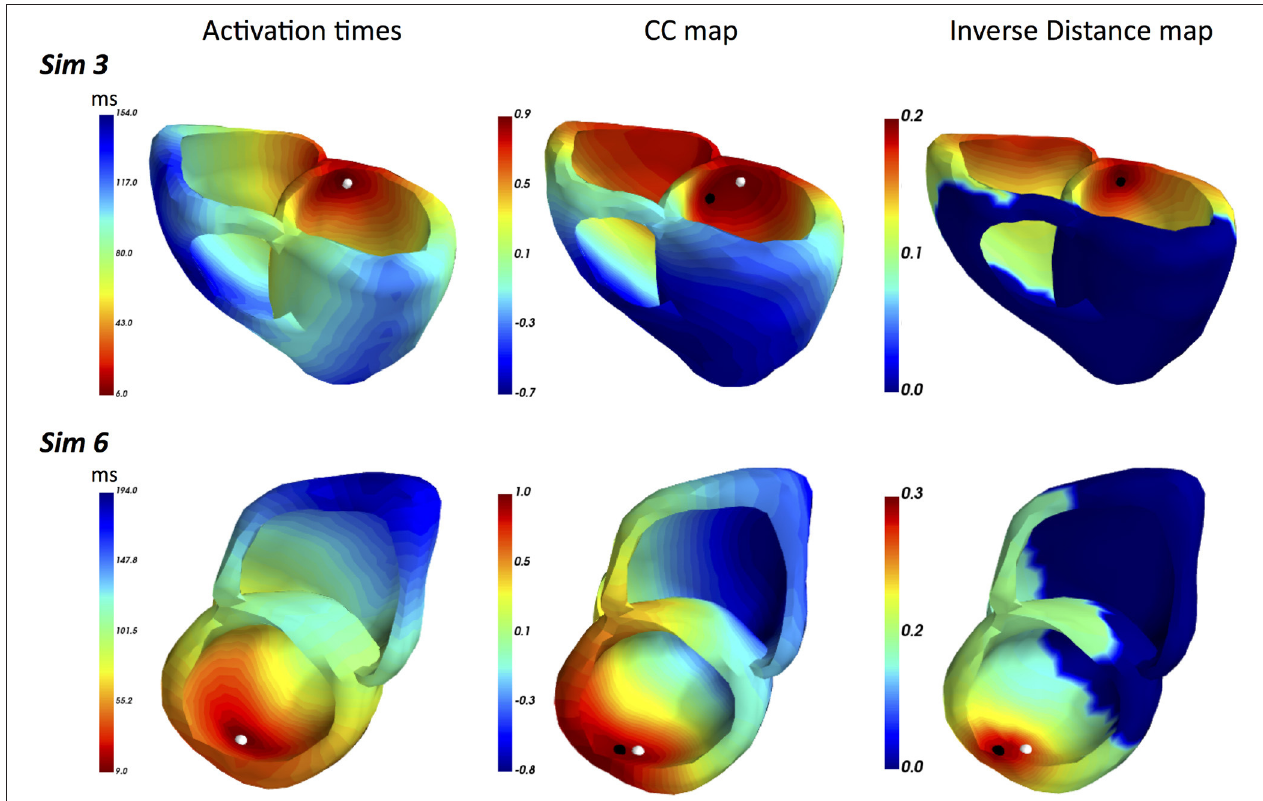
FIGURE 3 | ECGI results for realistic simulated patterns 3 and 6. For pattern 3, the combination of FRA with subsequent time warping exhibited the highest error decrease from 15 to 0mm. For this activation sequence, the onset reconstructed by FRA-DTW and marked by the black point coincides with the true focus. Pattern 6 was the only case among the considered eight, where the localization error provided by FRA-DTW was higher than that from the standard